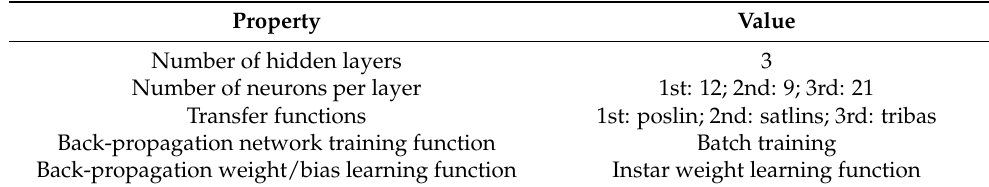
Table 2. Structure of hidden layers obtained by the artificial neural networks and the imperialist competitive algorithm (ANN-ICA) for the classification. Transfer functions: poslin: positive linear; satlins: symmetric saturating linear; tribas: triangular basis.